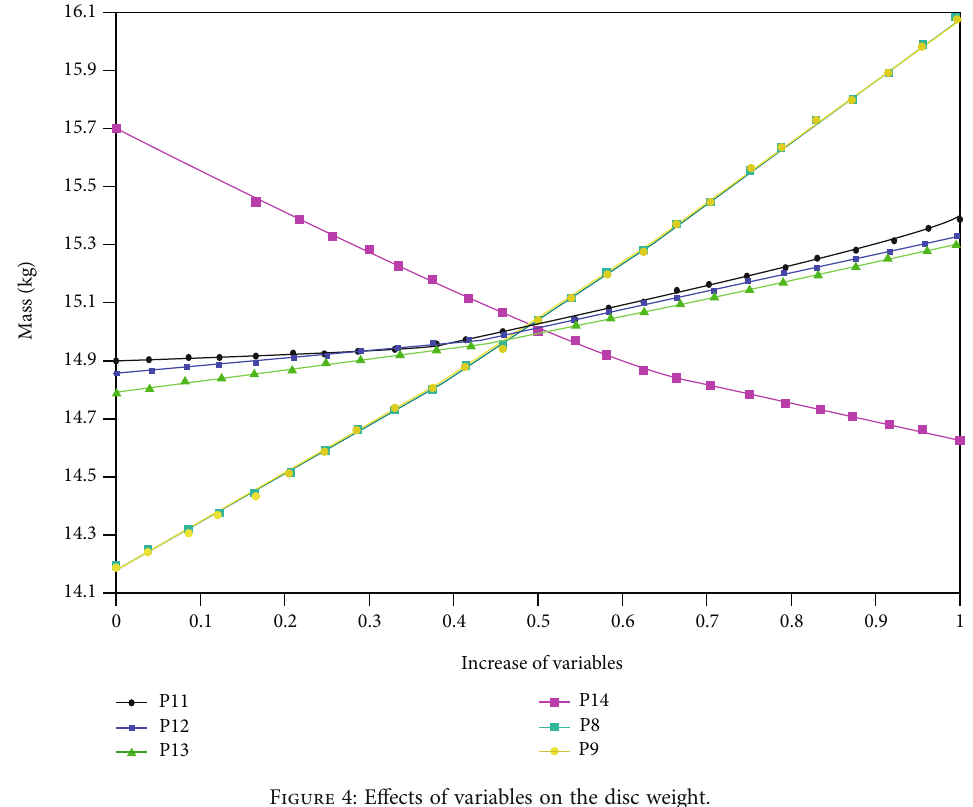
Figure 4: E ff ects of variables on the disc weight.